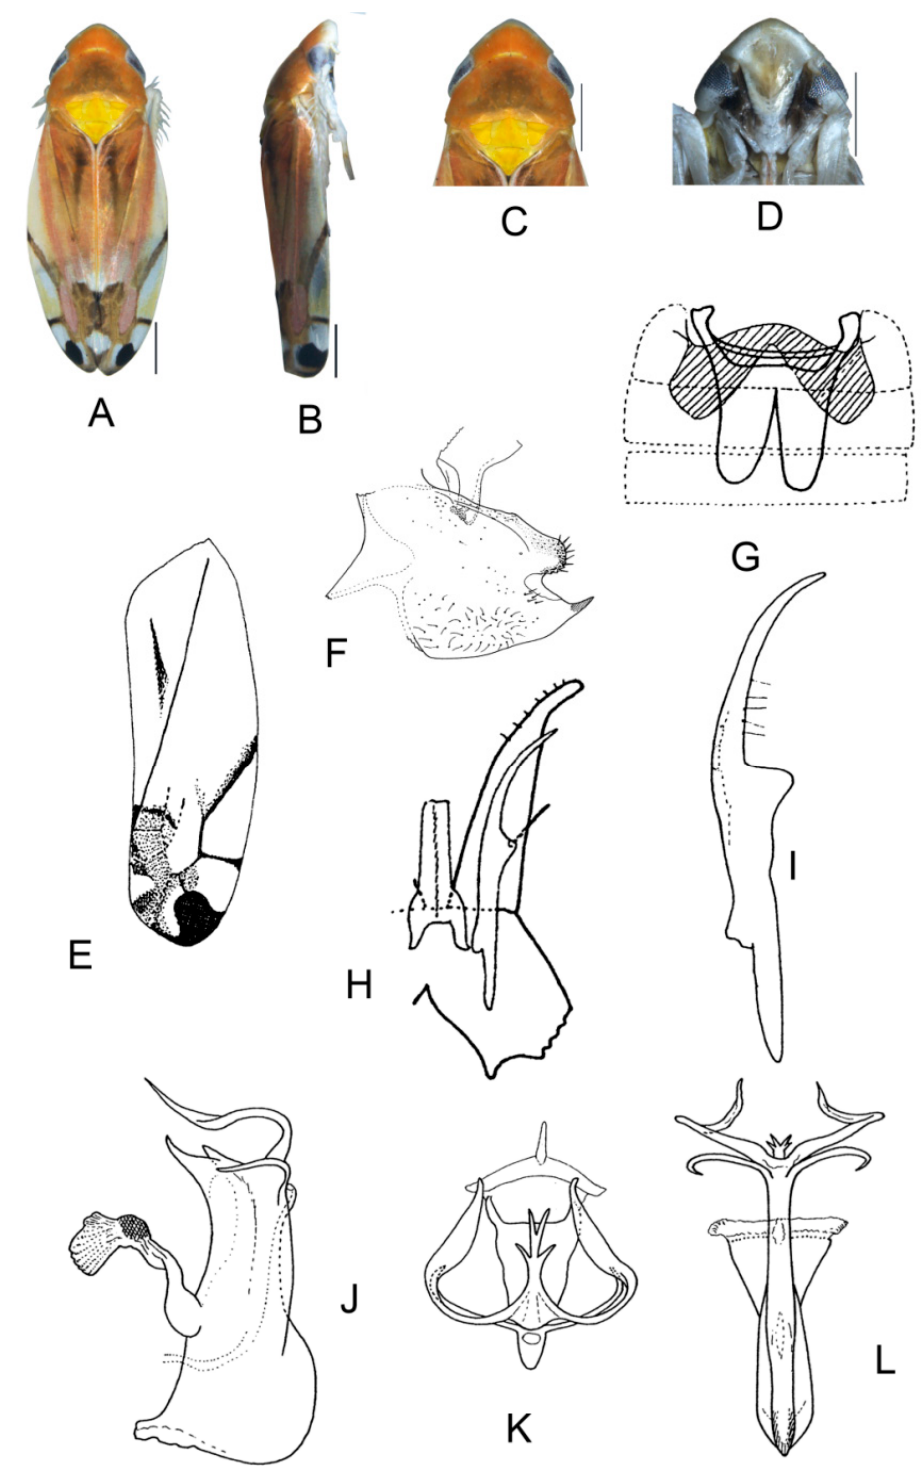
Figure 5. Eurhadina ( Singhardina ) rubra ( E – L : Dworakowska, 2002 [3]): ( A ) habitus, dorsal view; ( B ) habitus, lateral view; ( C ) head and thorax, dorsal view; ( D ) face; ( E ) forewing; ( F ) male pygofer side, lateral view; ( G ) abdominal apodemes, dorsal view; ( H ) subgenital plate, connective, paramere and sternite IX, dorsal view; ( I ) paramere, dorsal view; ( J ) apex of aedeagal shaft, dorsal view; ( K ) aedeagus, lateral view; and ( L ) aedeagus, posterior view. Scale bars: 0.5 mm. Eurhadina ( Singhardina ) rubrocorona Cai et Kuoh, 1993 Eurhadina ( Singhardina ) rubrocorona Cai et Kuoh, 1993: 223, Figure 2 [9]. Material examined. 8 ♂ , China, Fujian Prov., Sangang, 1984.VIII.8, coll. Zhixin Cui; 1 ♂ , China, Fujian Prov., Sangang, 1960.VI.25, coll. Yiran Zhang; 1 ♂ , China, Guizhou Prov., Mt. Fanjing, 2001.VII.28, coll. Qiang Sun; 3 ♂ , China, Zhejiang Prov., Mt. Fengyang, 2003.VIII.08, coll. Wu Dai; 1 ♂ , China, Zhejiang Prov., Mt. Gutian, 2003.VIII.17, coll. Wu